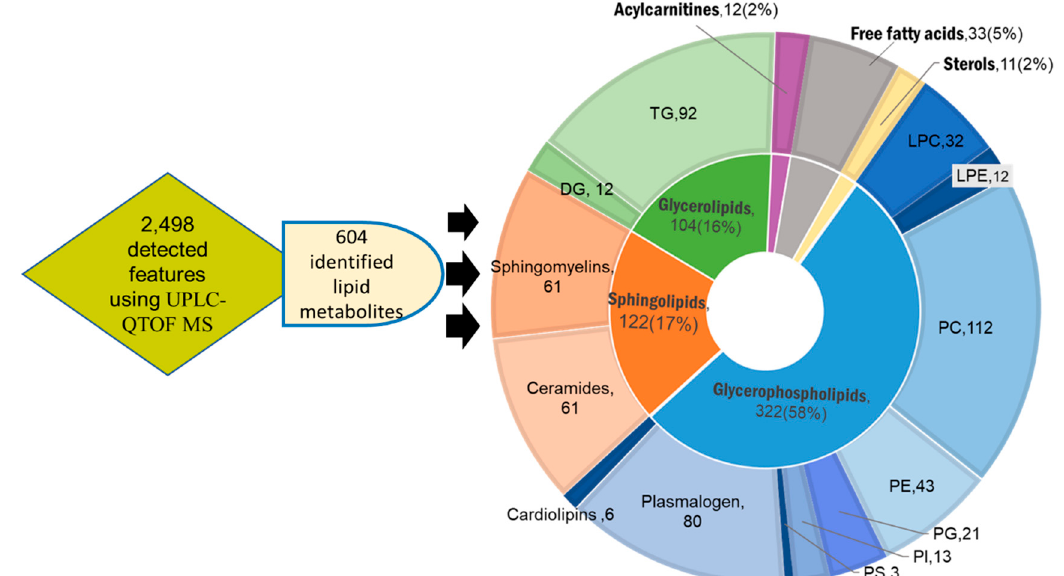
Figure 1. Overview of lipids identified in blood and tissue samples of hepatocellular carcinoma (HCC), chronic liver disease (CLD) and healthy control whole blood subjects using UPLC–QTOF MS. Inner circle: categorization into 6 lipid super classes: purple, acylcarnitines; grey, free fatty acids; yellow, sterols; blue, glycerophospholipids; orange, sphingolipids; green, glycerolipids. Outer circle: categorization into 16 subclasses matching the colors of the related superclasses. Each lipid class is presented with the number of its members and percentage of the total identified lipid metabolites.